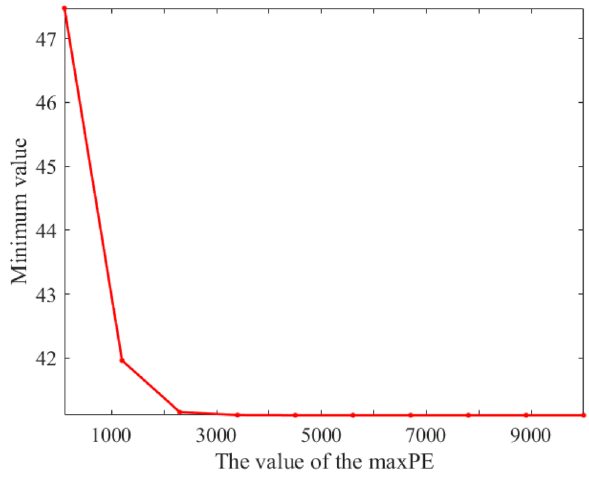
Fig. 10 Value of fitness function of